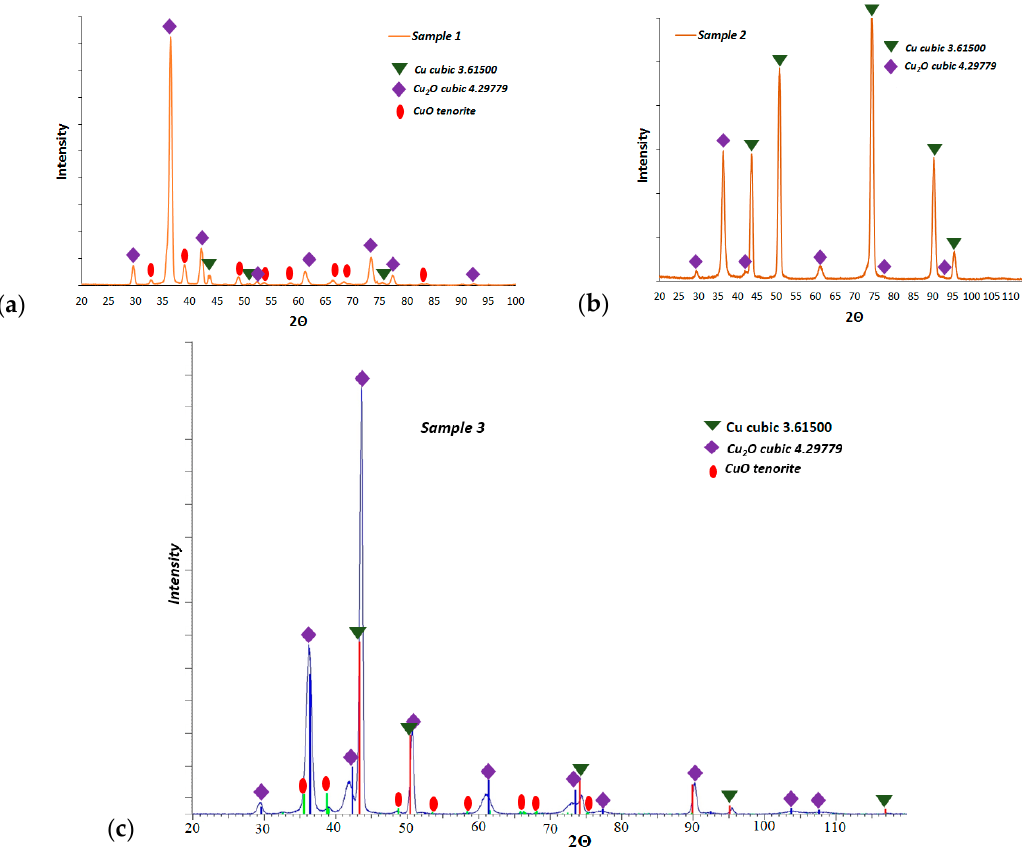
Figure 6. Diffraction and phase analysis results of investigated samples: ( a ) L1-1, ( b ) L2-4, and ( c ) L3-1.